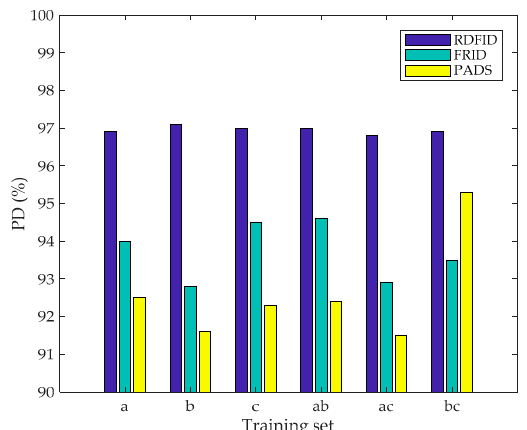
Figure 8. The probability of detection (PD) of human detection in different scenarios.